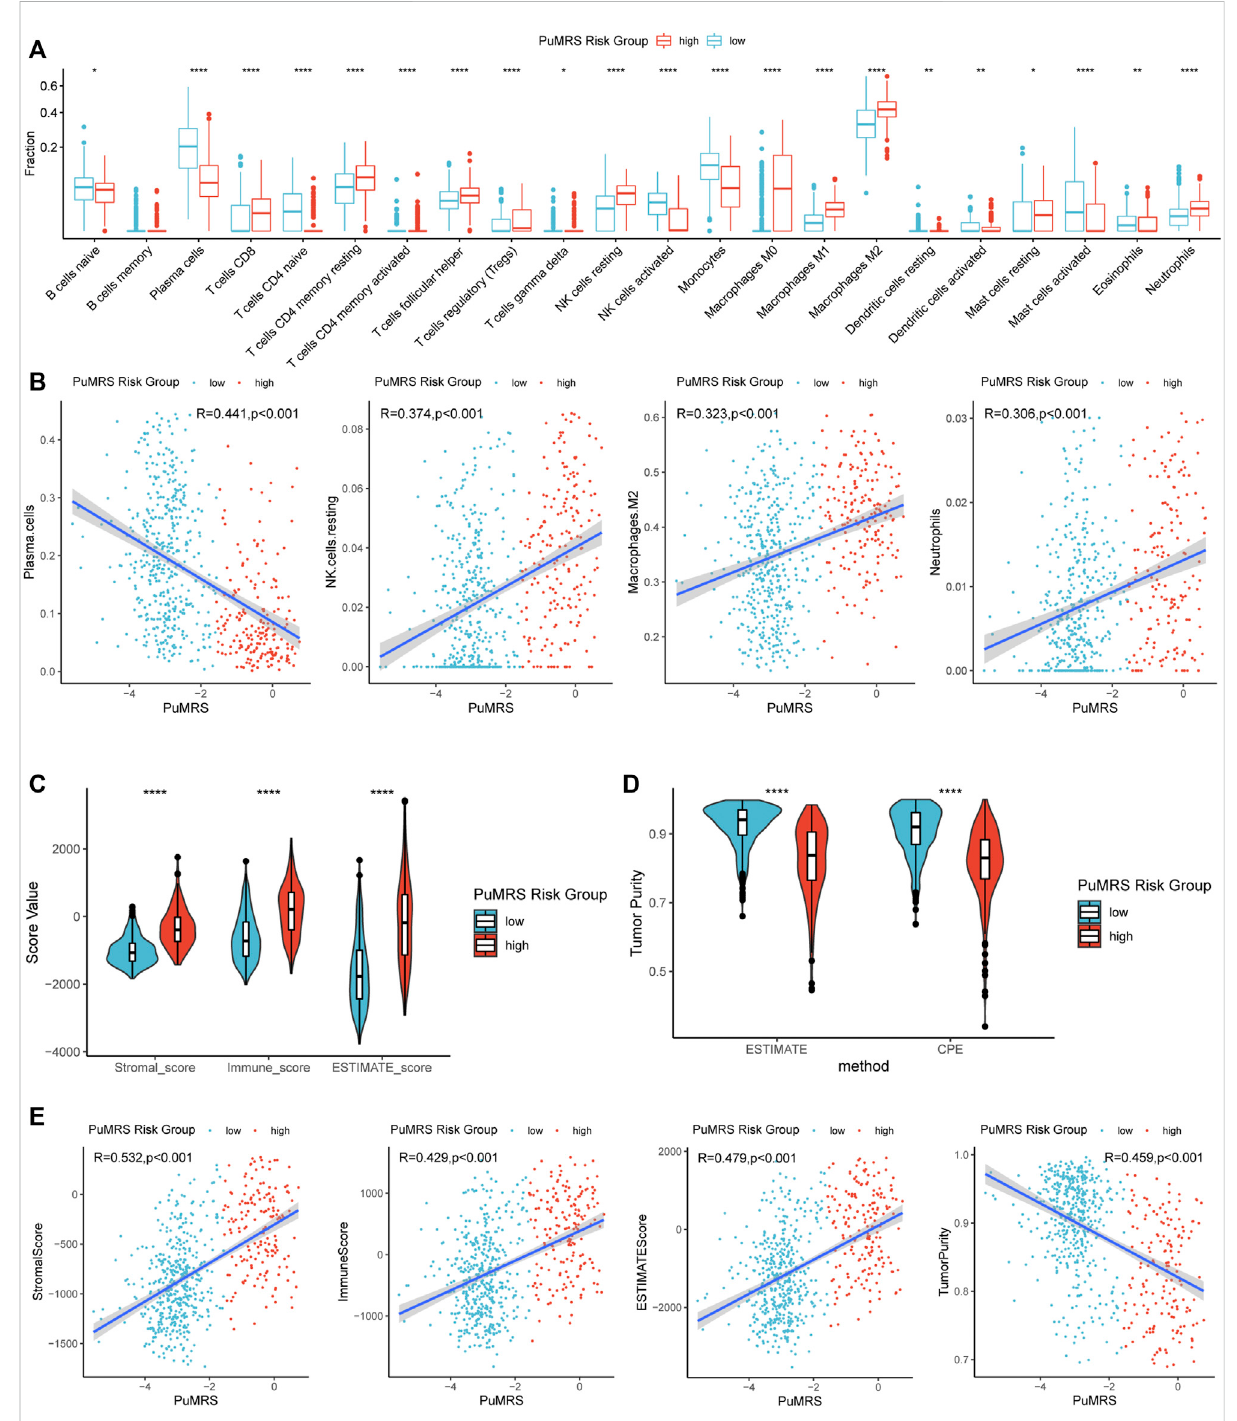
FIGURE 8 Differences in immune features of tumor microenvironment between two PuMRS risk groups. (A) Boxplot of the estimated fraction of 22 immune cells in tumors. (B) Analyses of correlations of PuMRS with the in fi ltration of plasma cells, resting NK cells, M2 macrophages, and neutrophils. (C) Stromal, immune, and ESTIMATE scores of the two risk groups. (D) Tumor purity of the two risk groups based on the ESTIMATE and CPEalgorithms. (E) AnalysesofcorrelationsofPuMRSwiththestromal,immune,ESTIMATEscore,andtumorpurity.* p < 0.05;** p < 0.01;*** p < 0.001; **** p <